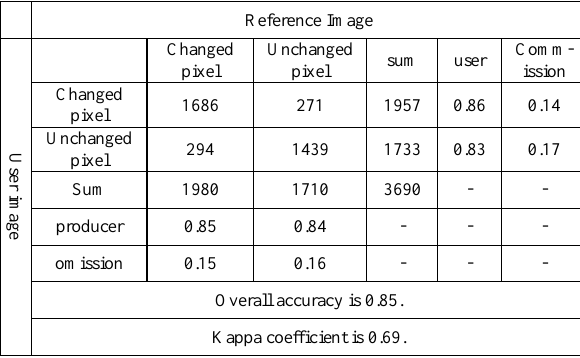
Table 4. Error matrix of pixel-base method with dNDVI